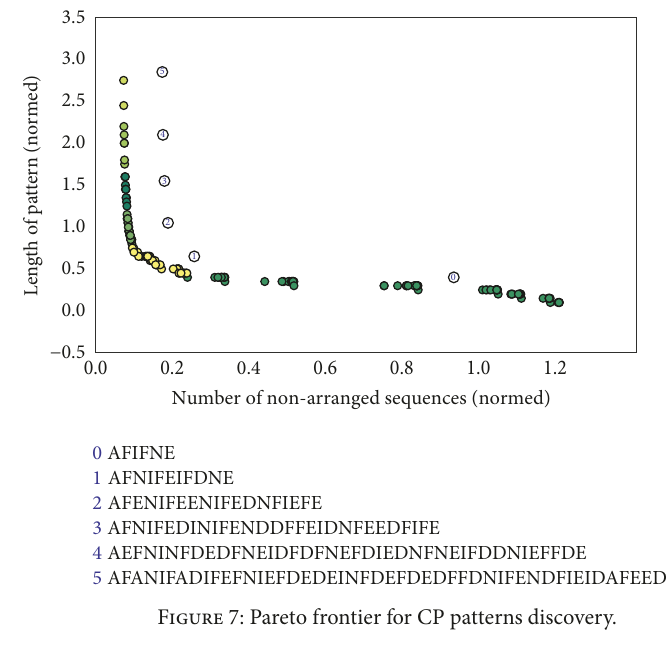
Figure 7: Pareto frontier for CP patterns discovery.